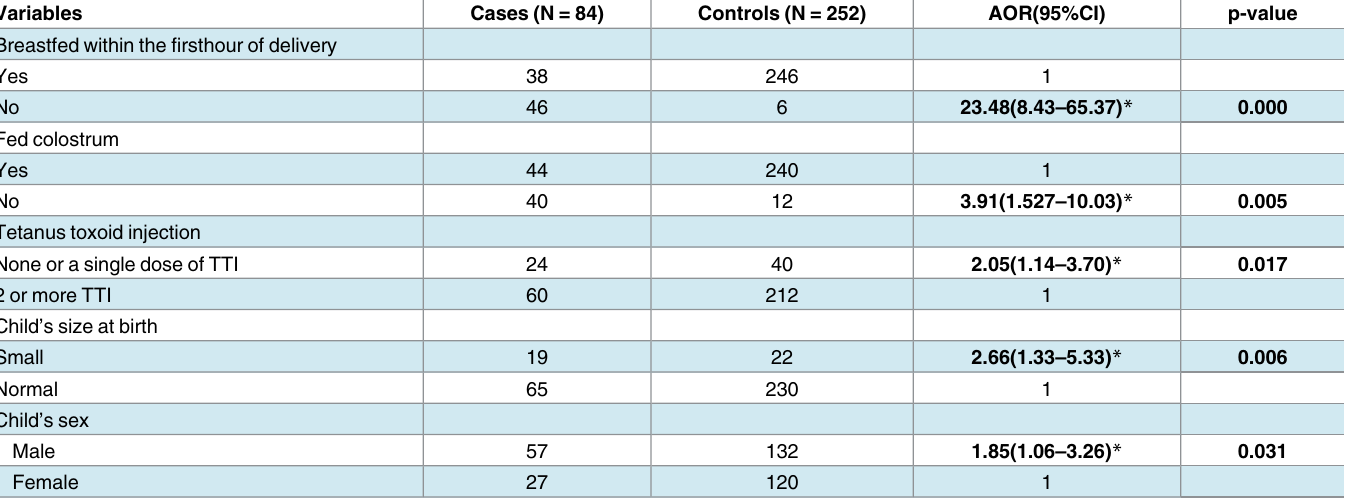
Table 4. Multivariate logistic regression analysis depicting the independent predictors of neonatal mortality in North Shoa Zone of Amhara Regional State,